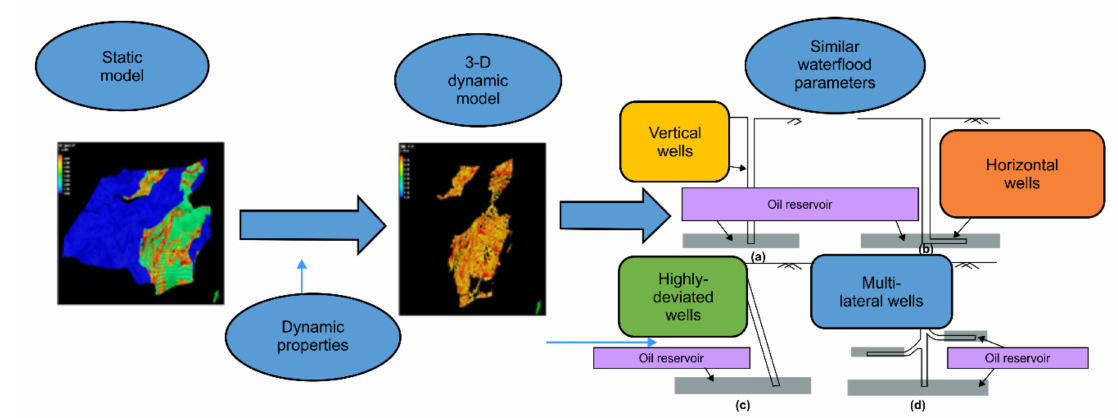
Figure 1. Summary of the workflow in the proposed model. Illustrations; ( a ), ( b ), ( c ), and ( d ) represent the different well types i.e., vertical, horizontal, highly deviated, and multilateral,